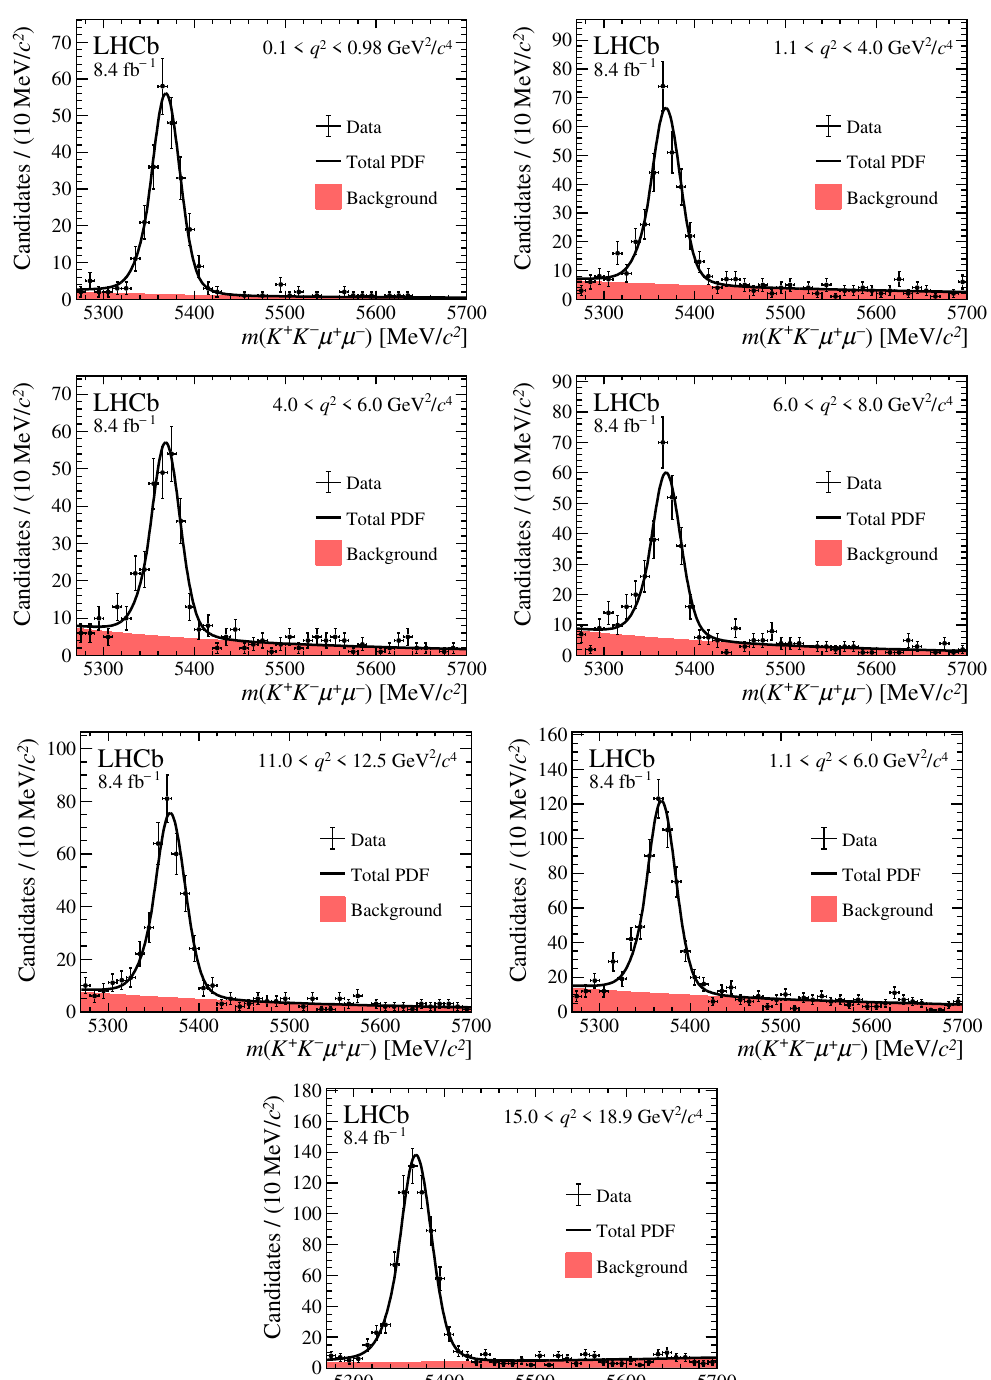
Figure 4 . Mass distributions of B 0 → φµ + µ − candidates in the different q 2 regions for the combined s 2011–2012, 2016 and 2017–2018 data sets. The data are overlaid with the projection of the combined PDF. The red shaded area indicates the background component and the solid black line the total